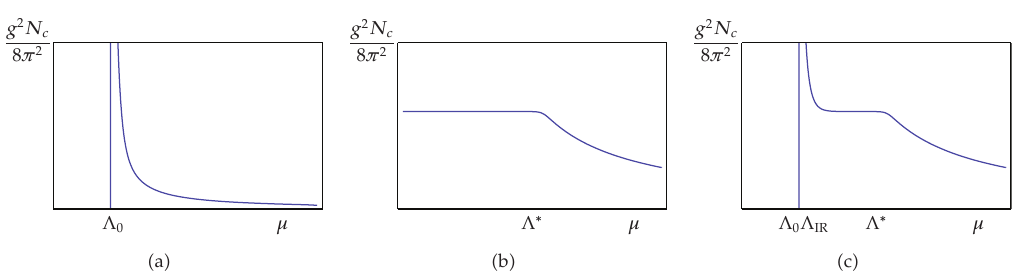
Figure 1: Schematic depiction of the evolution of the gauge coupling as a function of the renormalization scale in three di ff erent asymptotically free theories: a QCD-like theory, a theory with an IR fixed point, and a walking theory (cid:5) left to right (cid:6)